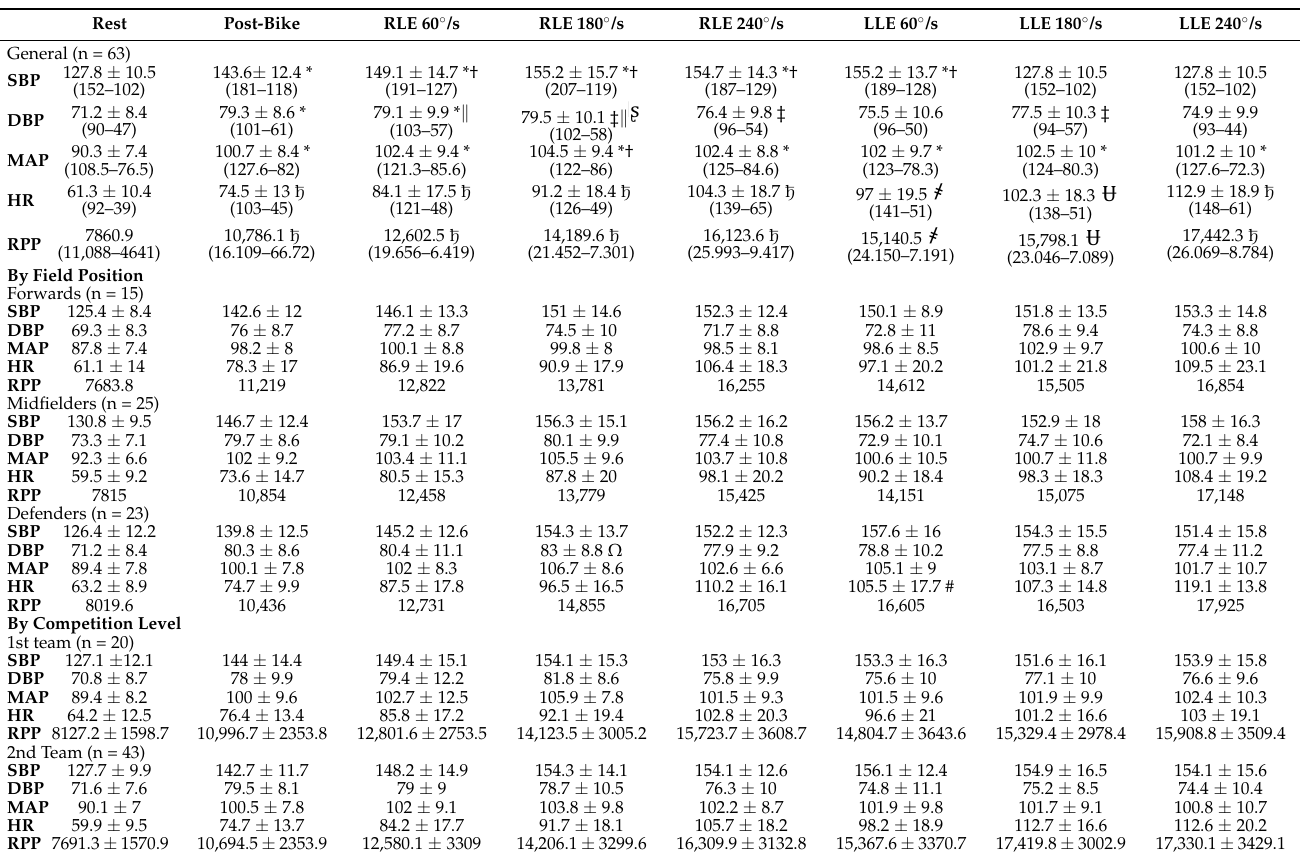
Table 1. Description of the cardiovascular parameters during the isokinetic protocol at different measurements. Means and standard deviations obtained for the global sample (n = 63) and according to the field position and competition level of the soccer players are shown.